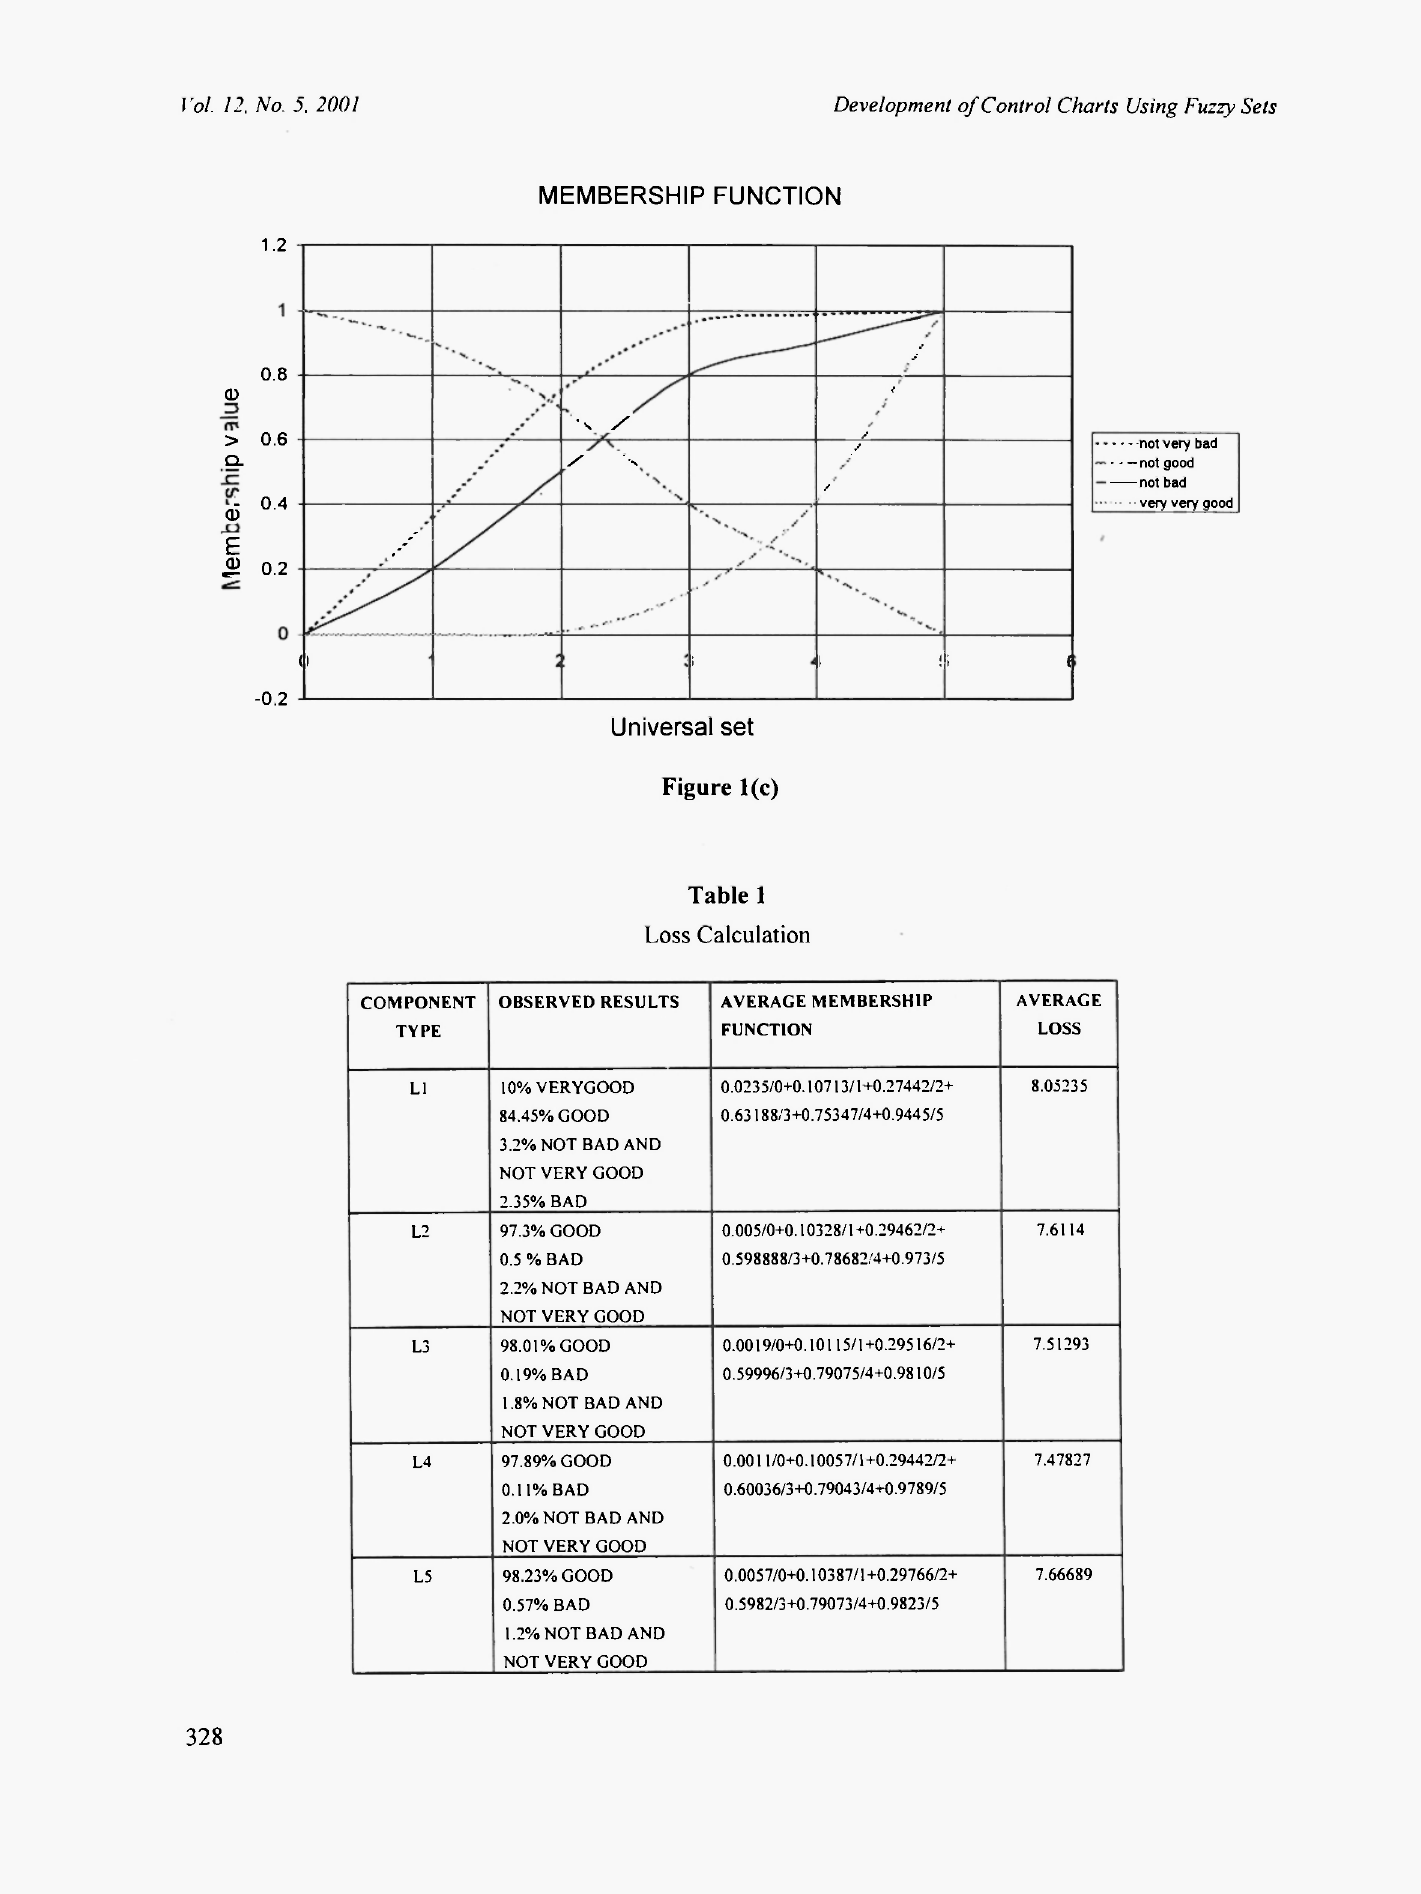
not very bad - - — not good not bad • • - - very very